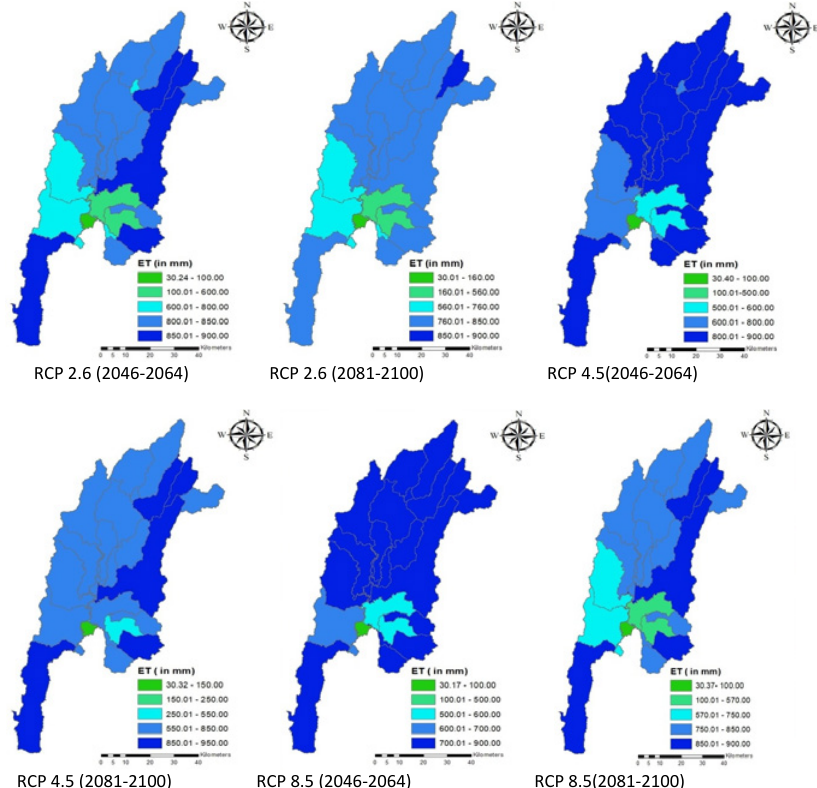
Fig. 8: Spatial distribution of evapotranspiration under different RCP scenarios for different time period